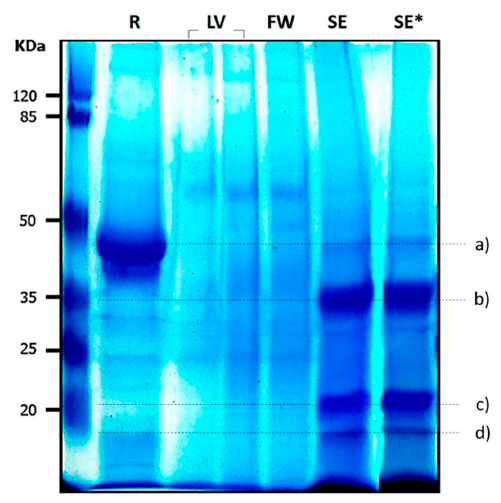
Figure 2. Electrophoretic pattern of Moringa oleifera crude extracts. R: Rennet, LV: Leaves, FW: flowers, SE: Seed extract, SE*: Seed extract macerated with ultrasonic bath. ( a – d ): Proteins of interest. Data are representative of three experiments.